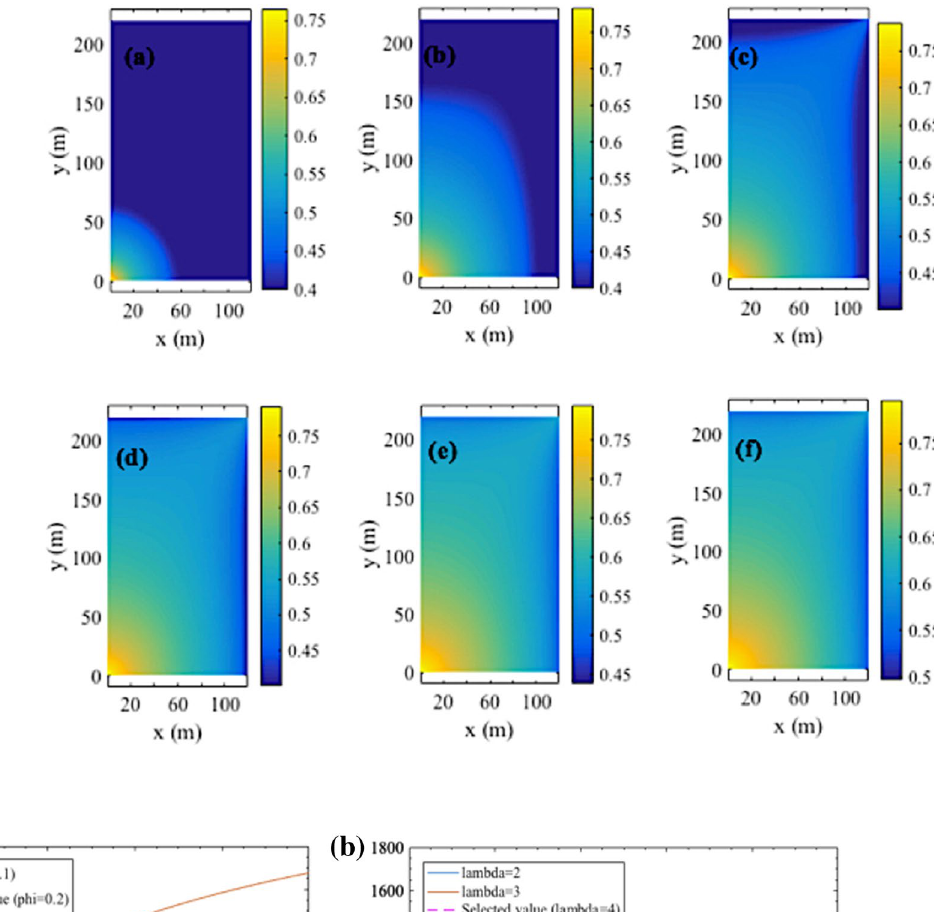
Fig. 4 Water saturation distribution at: a 10 days, b 50 days, c 100 days, d 200 days, e 500 days, and f 1000 days (injection well at the lower left corner; production well at the upper right corner)